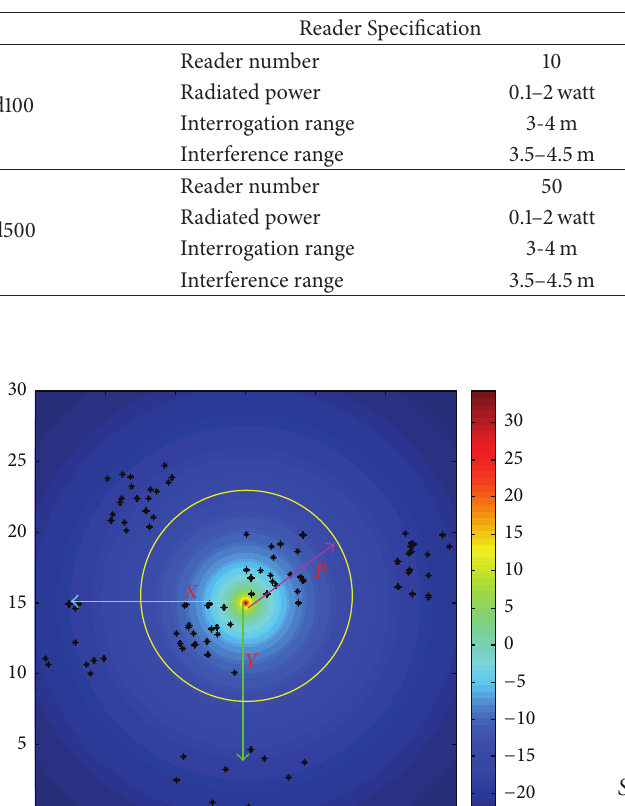
Table 6: The example for Cd100, Rd500 and Rd500.